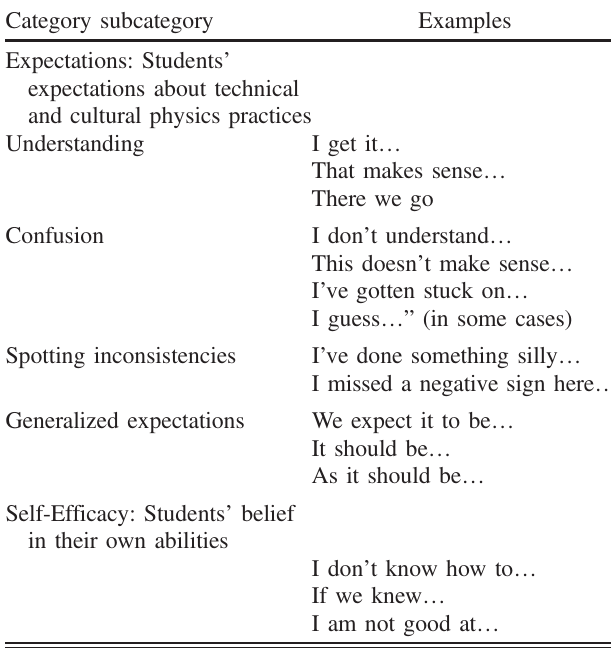
TABLE I. Kinds of BESM